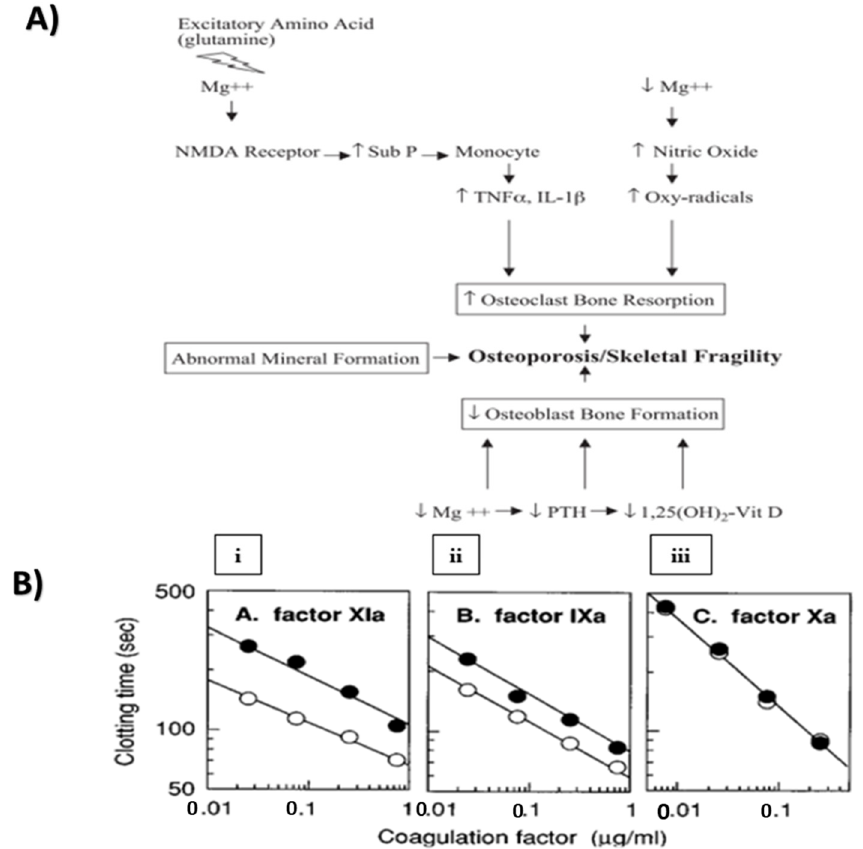
Figure 4. ( A ) Mechanism of Mg-induced bone loss. Adapted from [68]. Reproduced with permission from ASBMB Publications. ( B ) Dialyzed normal plasma was incubated with set concentrations of factor XIa ( i ), factor IXa ( ii ), and factor Xa ( iii ), and 200 mM phospholipids. Adapted from [60]. Reproduced with permission from Elsevier.